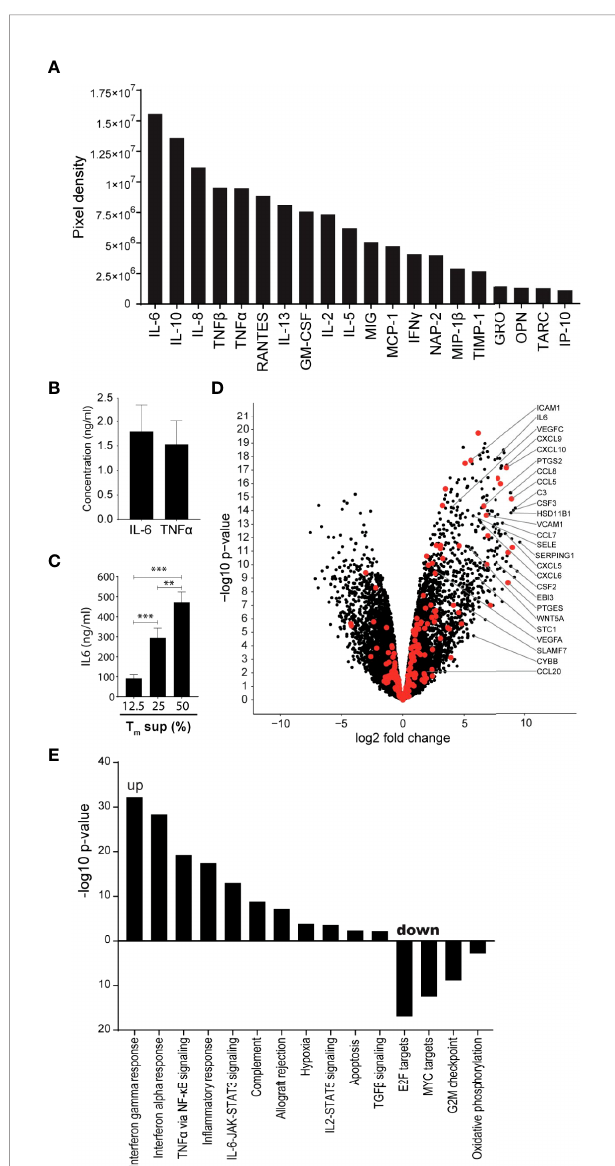
FIGURE 1 | T m sup stimulation drives in fl ammatory activation of ECs. (A, B) Puri fi ed Tm cells were cultured in presence of anti-CD3 and anti-CD28 for 72h after which culture supernatant was collected and pooled for 5 donors (T m sup). (A) Relative abundance, rated by pixel density, of indicated cytokines in T m sup measured by cytokine antibody array technology. (B) Quanti fi cation of IL-6 and TNF a concentrations in T m sup by ELISA. Mean and SEM of experimental duplos is shown. (C) ECs were stimulated with T m sup for 72h. Quanti fi cation of IL-6 protein production by ECs ( n= 6). Control samples (RPMI medium) or unstimulated ECs did not produce detectable levels of IL-6 (not shown). (D, E) RNA sequencing was performed on ECs after 72h of T m sup stimulation. (D) Volcano plot showing changes in gene expression in T m sup stimulated vs unstimulated ECs. Enrichment (x-axis, log2 fold change) is plotted against signi fi cance (y-axis, -log10 p -value). Selected genes were annotated and NF- k B associated genes are highlighted in red. (E) Differentially expressed Hallmark gene sets in T m sup stimulated vs unstimulated ECs. For MYC targets, Hallmark gene set MYC targets V2 is shown, similar results were obtained for MYC targets V1 . -log10 p -value of 1.3 corresponds to p= 0.05. **p < 0.01, ***p <